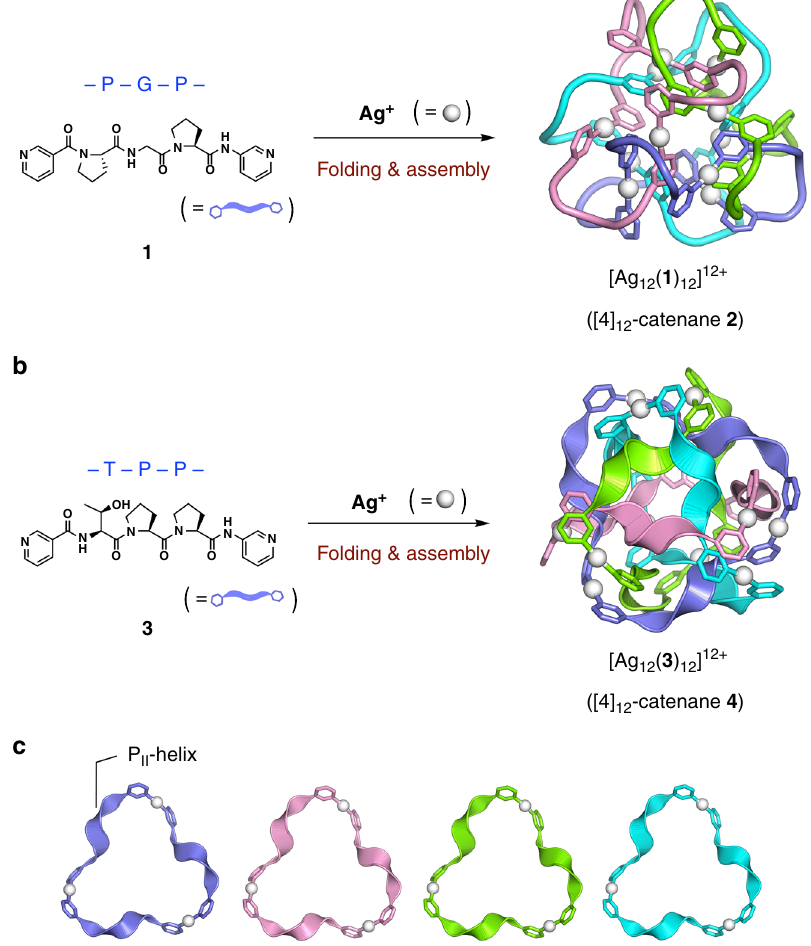
Fig. 2 Formation of two types of [4] 12 -catenane. a Schematic representation of the formation of [4] 12 -catenane 2 by Ag(I) ion-mediated folding and assembly of tripeptide ligand 1 , which was previously reported by our group 16 . b New [4] 12 -catenane topology 4 , obtained through the same folding-and- assembly strategy but using tripeptide ligand 3 . c Four Ag 3 ( 3 ) 3 macrocyclic components based on the P II -helix conformation extracted from the structure of (Supplementary Figs. 1b and 4), 1 H NMR measurements (Sup- plementary Fig. 11c, d), and mass spectrometry (MS) analysis